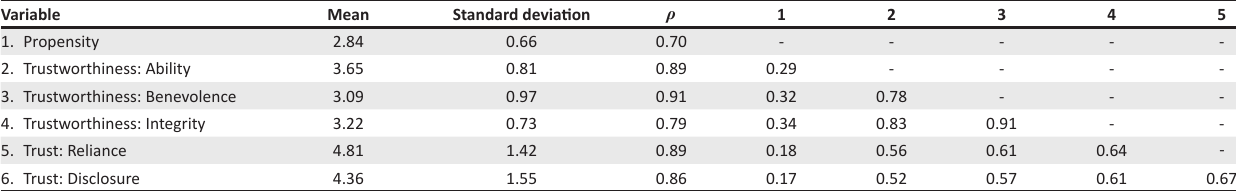
TABLE 2: Descriptive statistics, reliabilities and correlations of the scales Variable